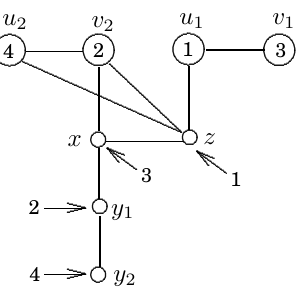
Figure 3: The graph G